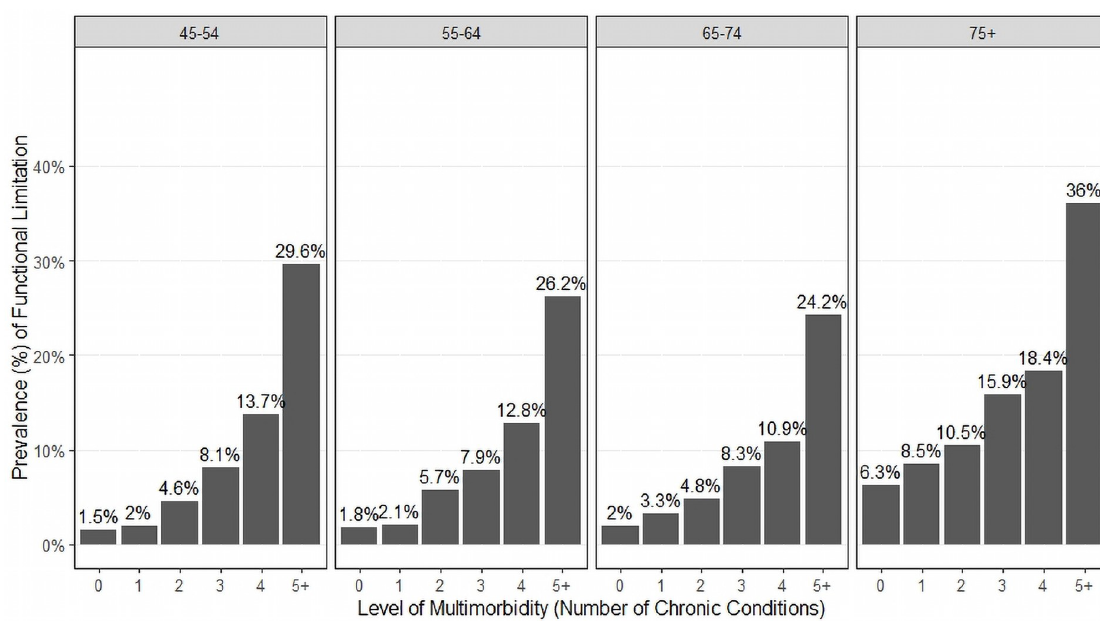
Fig 2. Prevalence of functional limitation by multimorbidity and